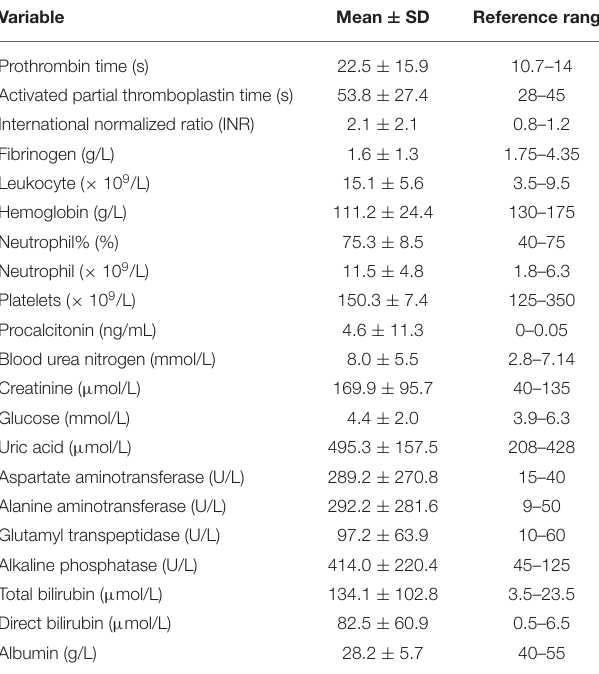
TABLE 3 | Laboratory findings of patients with AFLP ( n = 106).